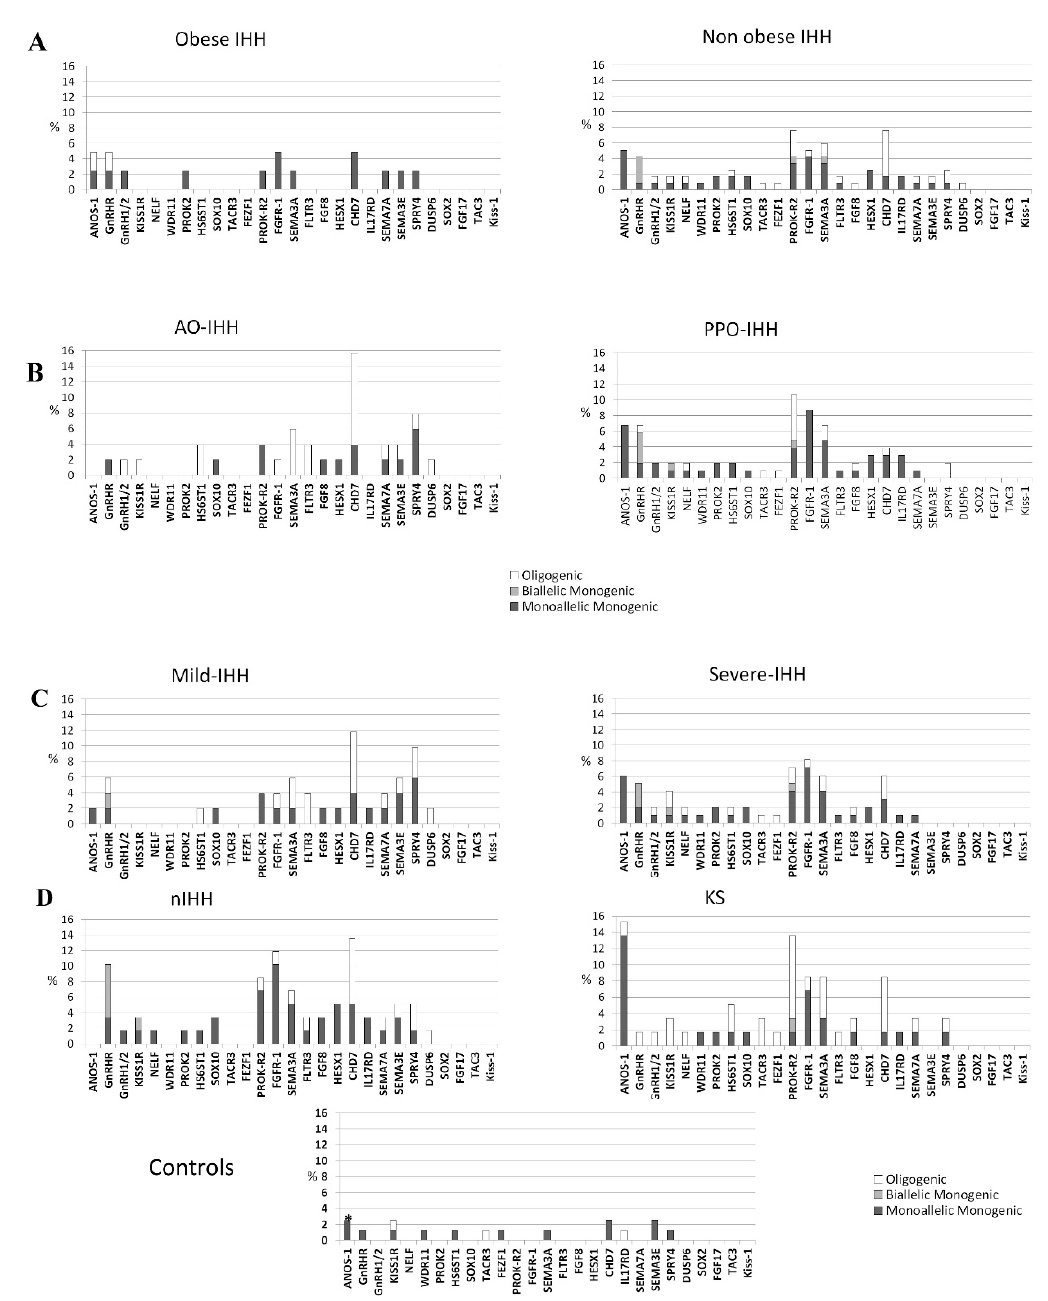
Figure 3. Distribution of rare variants among the 28 candidate genes in the different IHH groups. Showed according to the presence of obesity ( A ), age of IHH onset ( B ), TTe levels ( C ) and olfactory defects ( D ). IHH (isolated hypogonadotropic hypogonadism), AO (adult onset), PPO (prepubertal onset), mIHH (mild IHH), sIHH (severe IHH), KS (Kallmann’s Syndrome), nIHH (normoosmic